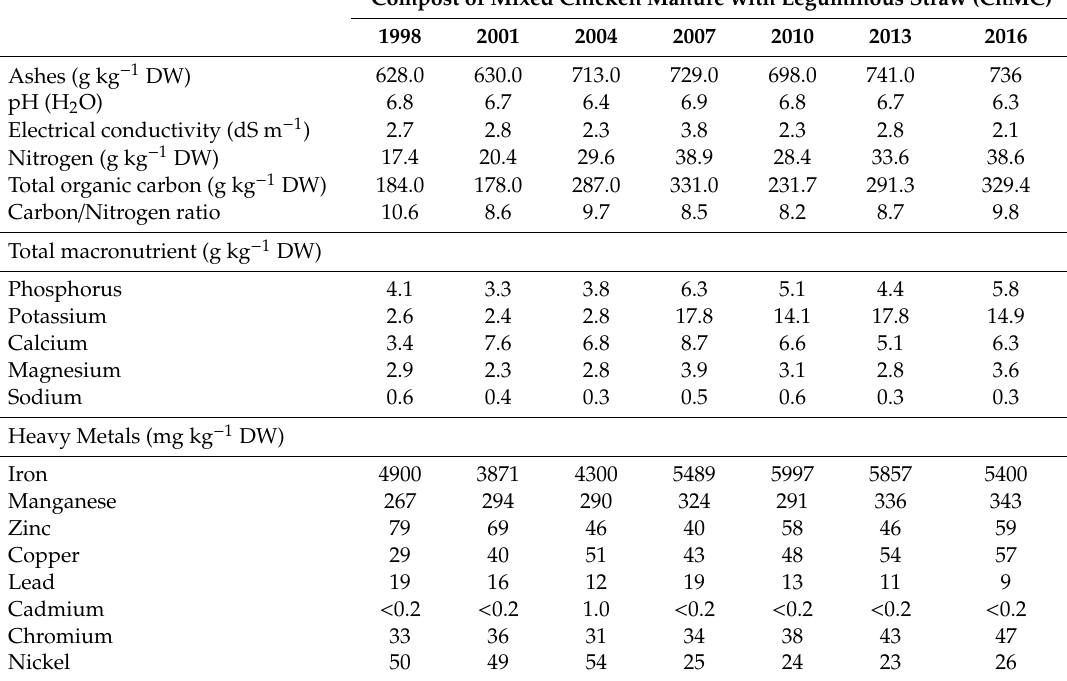
Table 5. Main analytical characteristics of the compost obtained from the mixture of chicken manure with leguminous straw (ChMC) and applied to the soil in the years of